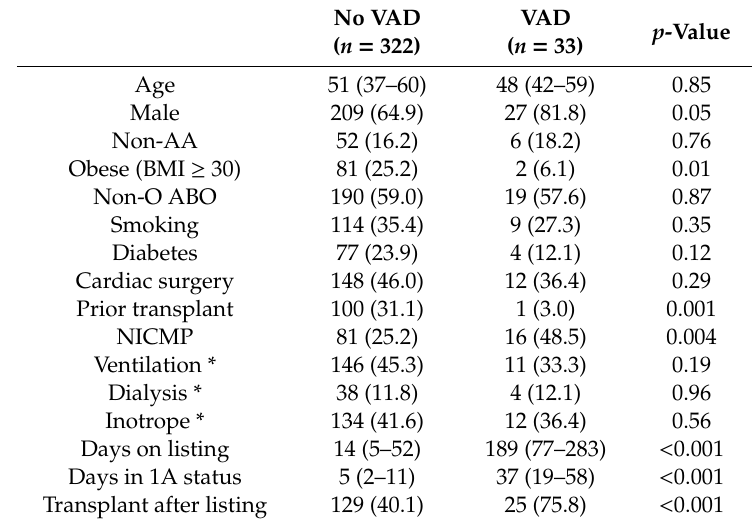
Table 3. Demographic and clinical characteristics in patients who had VAD implantation during listing.